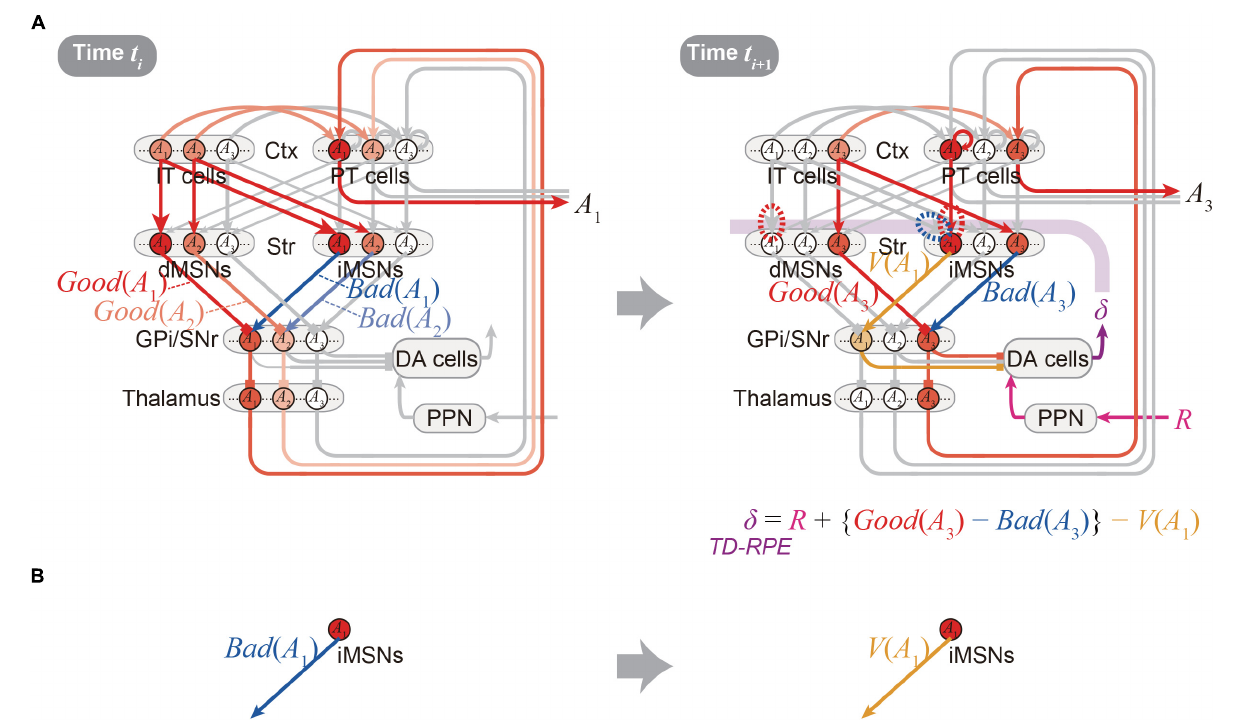
FIGURE 3 | Detailed operation of the OTD model, and reversal of the valence in the coding of the indirect pathway predicted by the model. (A) Detailed operation of the OTD model. ( Left panel ) At time t i , goodness (benefit) and badness (cost) of each of the two action candidates, A 1 and A 2 , are represented in the direct and indirect pathways, respectively. Based on the utility combining those benefit and cost, one action, A 1 , is selected in a soft-max manner to be represented by a population of PT neurons, and executed through the pyramidal tract. ( Right panel ) At time t i + 1 when reward comes as an outcome of the executed action A 1 , the A 1 -corresponding population of PT neurons sustain their activity, activating the A 1 -corresponding population of iMSNs. These iMSNs represent the value of the executed action [ V ( A 1 )], and negatively impact the DA neurons via GPi/SNr. In the meantime, goodness (benefit) and badness (cost) of the upcoming action A 3 , i.e., Good ( A 3 ) and Bad ( A 3 ) are represented in the A 3 -corresponding populations of dMSNs and iMSNs, respectively, which positively and negatively impact the DA neurons. Together with reward-representing input R , the DA neurons calculate a form of TD-RPE: R + { Good ( A 3 ) − Bad ( A 3 )} − V ( A 1 ) [results of recent work (Kim et al., 2015) imply that DA neurons involved in learning of stable values do not receive reward-representing input R ; they may represent TD error: Good ( A ( t i + 1 )) − Bad ( A ( t i + 1 )) − V ( A ( t i ))]. When this TD-RPE/TD-error is positive, the A 1 -corresponding IT-dMSN connections and IT-iMSN connections are potentiated and depressed, respectively, and the A 1 -corresponding PT-iMSN connections are potentiated. These differential plasticity inductions depending on both cortical and striatal neuron types in turn lead to the representations of benefit, cost, and action value by each pathway. (B) The OTD model predicts a reversal of the bad–good valence in the coding of the indirect pathway: the A 1 -corresponding iMSN initially represents the badness (cost) of A 1 (left) but later represents the value ( ≈ goodness – badness) of the same A 1 (right).